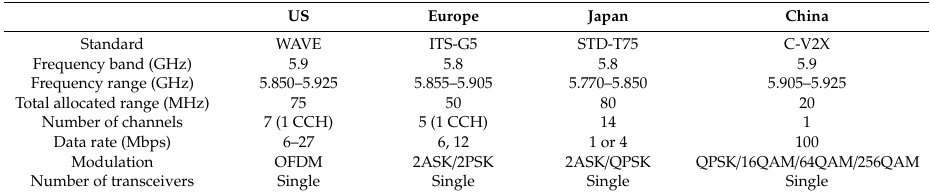
Table 1. Comparison of vehicular communication